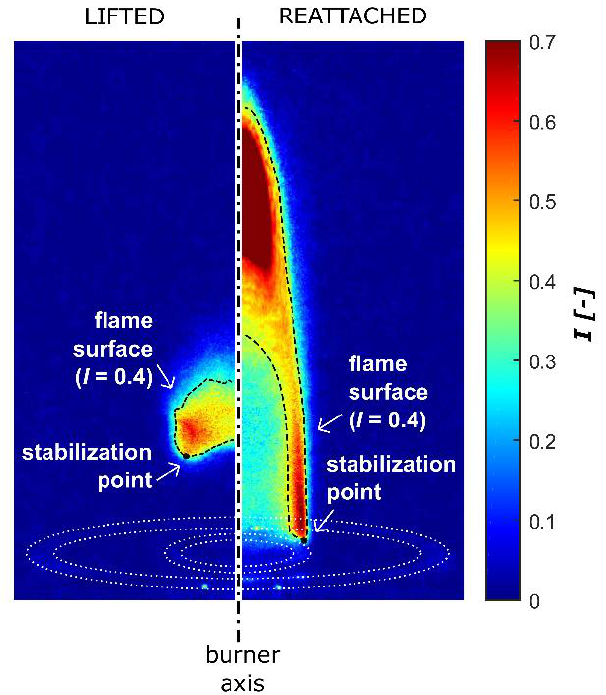
Figure 6. Flame structure modification: lifted flame condition without plasma actuation (test 1) on the left; reattached flame condition in presence of plasma actuation (test 2) on the right. The white dotted curves represent the burner lips at the exit section.